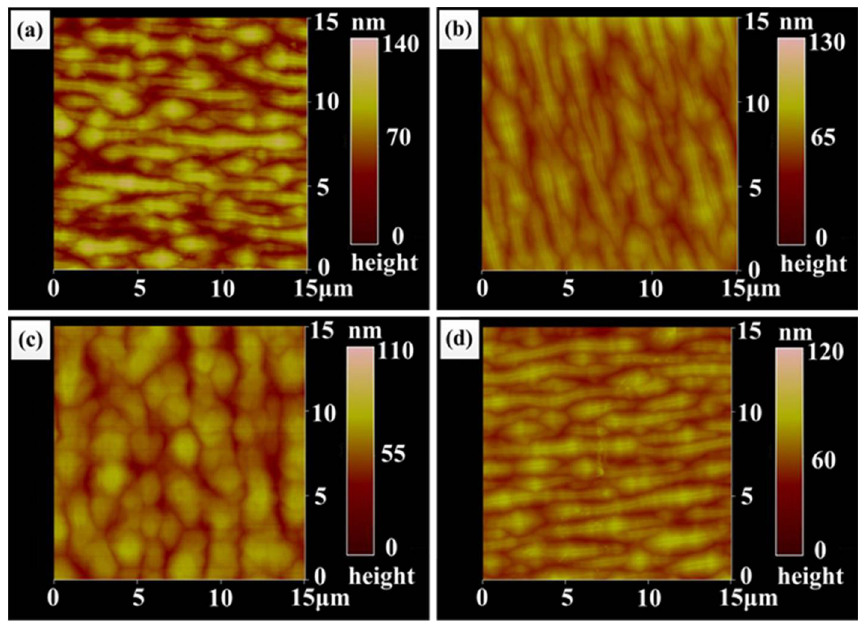
Figure 1. Atomic force microscope (AFM) images of the In 0.82 Ga 0.18 As epitaxial layers of four samples: ( a ) sample A; ( b ) sample B; ( c ) sample C and ( d ) sample D. ( a ) sample A; ( b ) sample B; ( c ) sample C and ( d ) sample